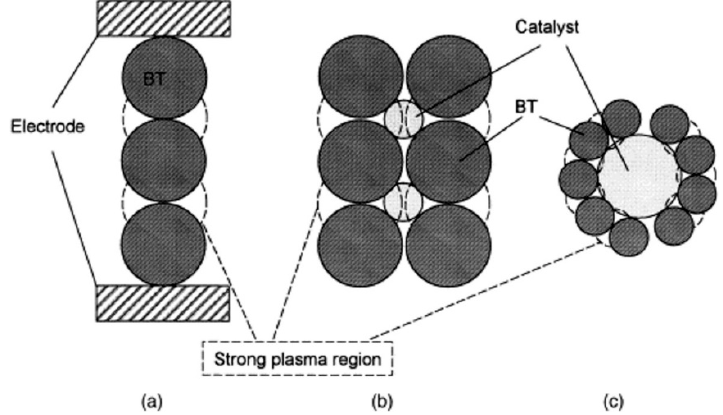
Figure 18. Representation of plasma discharge in ( a ) a conventional reactor packed with BaTiO 3 (BT) alone and the reactors packed with a mixture of BaTiO 3 (BT) and adsorbent Al 2 O 3 catalyst ( b ) BT > Al 2 O 3 and ( c ) BT < Al 2 O 3 . Reprinted from Reference [55], with permission from Elsevier.